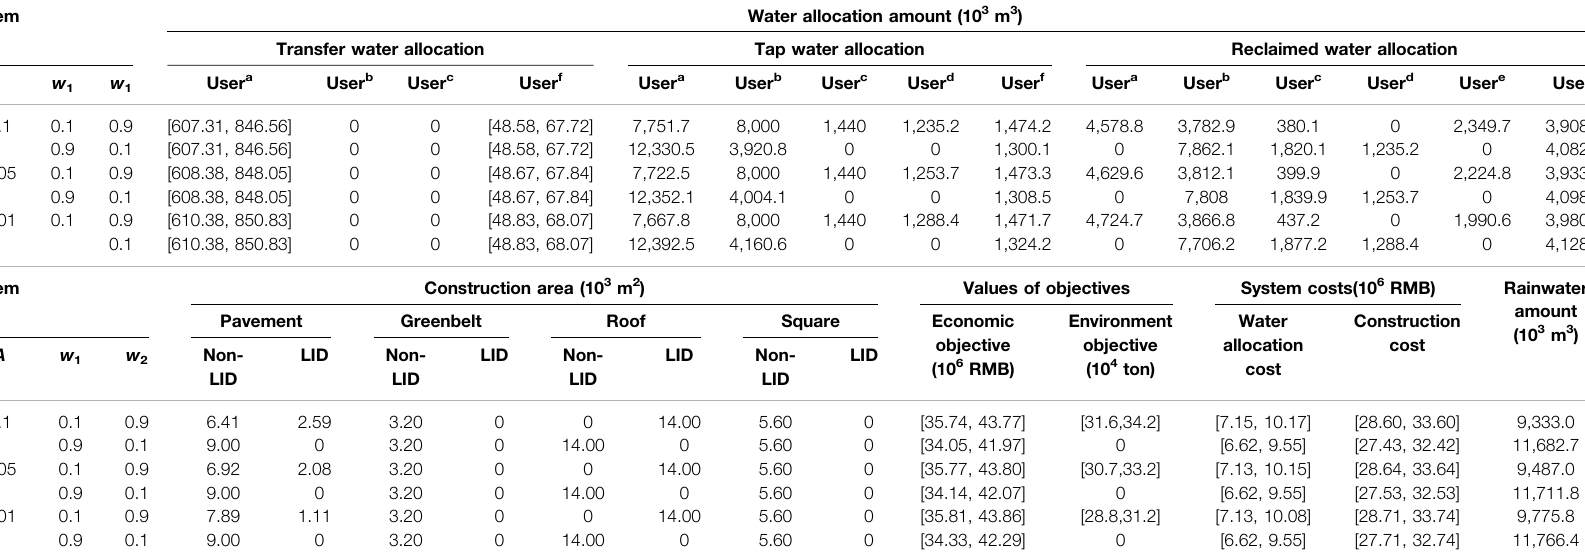
TABLE 4 | Part of solutions of multi-objective interval birandom chance-constrained programming model under various α values and weight